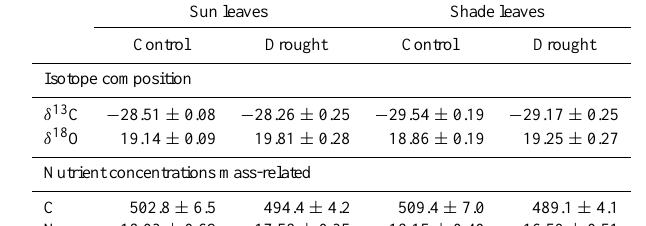
Table 4. Summary of means ( ± 1SE, n = 5) of branch wood anatomical and hydraulic traits from the sun canopy of C. acumi- natissima . Vessel lumen area ( A Lumen ) , vessel density (VD), mean vessel diameter ( d) , hydraulic mean vessel diameter ( d h ) , theoreti- cal sapwood-specific conductivity ( k S ) are shown.